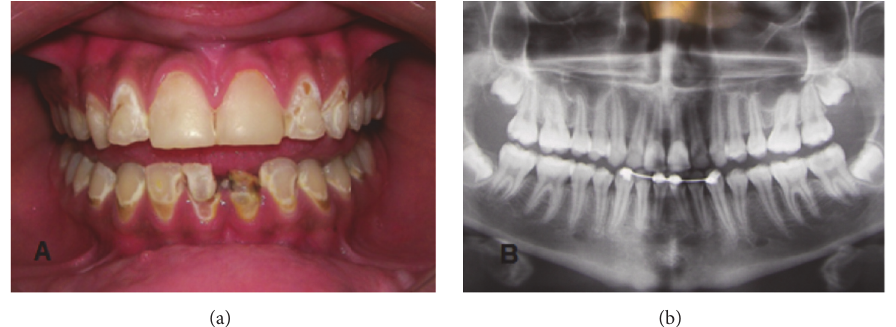
Figure 1: (a) The initial clinical appearance demonstrating carious lesions on buccal regions; (b) radiographic examination showing the fixed lingual orthodontic appliance for treatment contention and carious lesions.